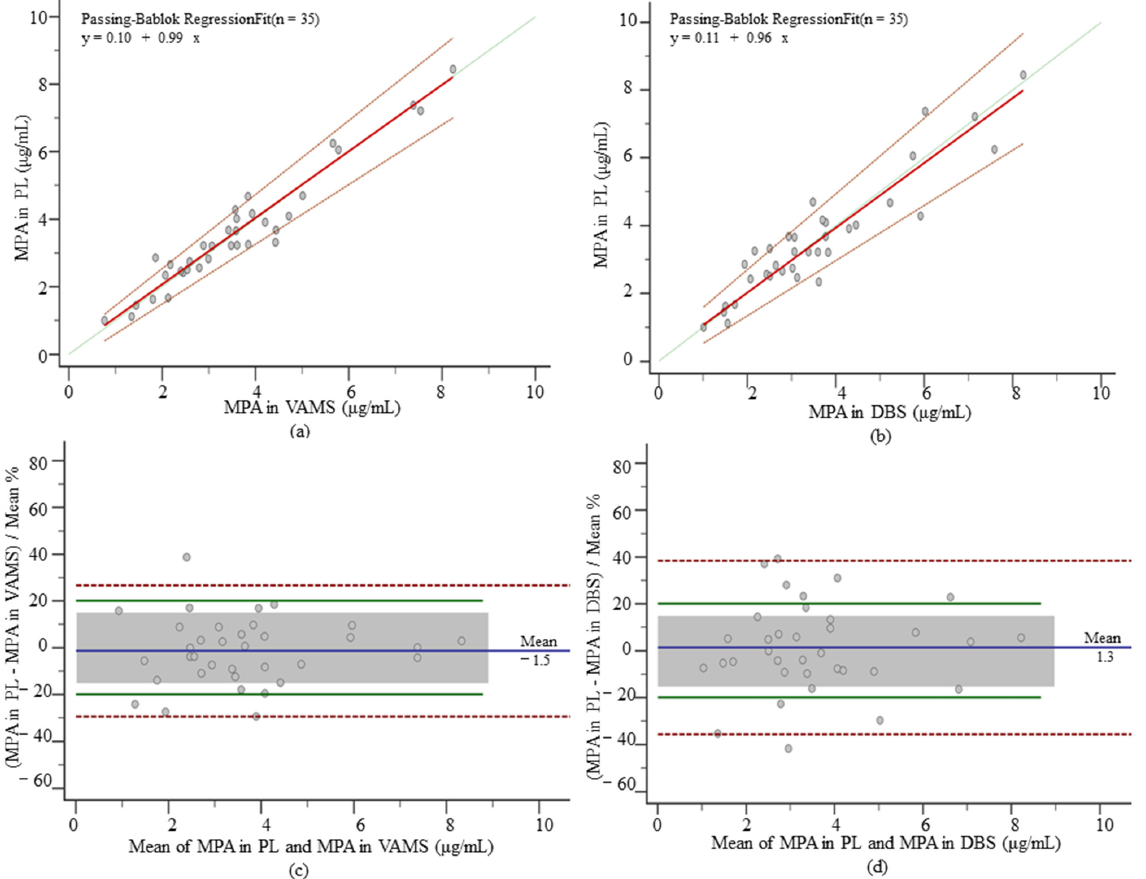
Figure 4. PB regression and Bland–Altman plot for MPA. ( a ) PB regression of corrected MPA concentrations in VAMS samples and plasma samples, the solid red line is the regression line, the dashed red line is the 95% CI, and the solid green line is the identity; ( b ) PB regression of corrected MPA concentrations in DBS samples and plasma samples; ( c ) Bland–Altman plots of plasma MPA concentrations and corrected VAMS plasma concentrations. The blue solid line is the mean deviation, the red dashed line is the 95% CI, the green solid line is the APE acceptance limit ( ± 20%), and the grey box is the set clinical acceptance limit ( ± 15%), the following MPA and Cre as well; ( d ) Bland–Altman plots of plasma MPA concentrations and corrected DBS plasma